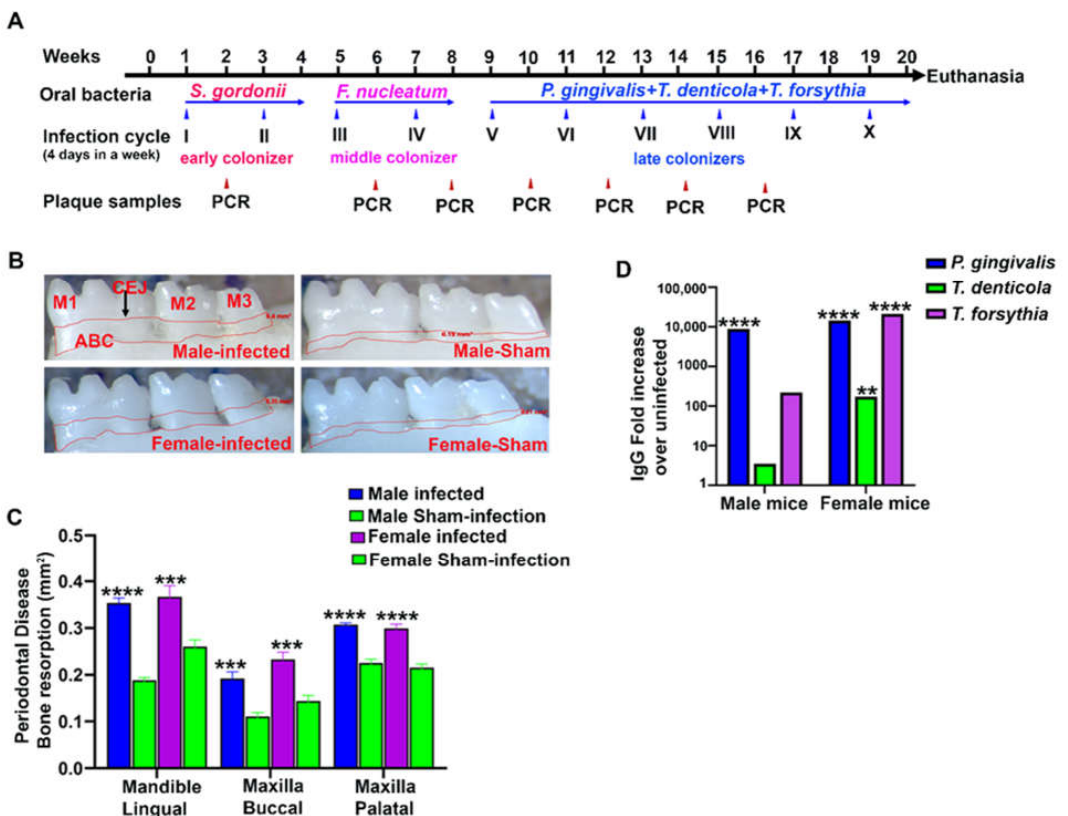
Figure 1. Gingival infection of periodontal bacteria significantly induced alveolar bone resorption (ABR) and elicited an IgG immune response in male and female mice. ( A ) Schematic diagram of the experimental design depicting the ecological time-sequential polybacterial periodontal infection (ETSPPI) model with early, middle, and late colonizers (4 days per week on every alternate week), plaque sampling for PCR and euthanasia. ( B ) Representative images showing horizontal ABR (mandible lingual view) of ETSPPI mice and sham-infected mice with the area of bone resorption outlined from the alveolar bone crest (ABC) to the cementoenamel junction (CEJ). ( C ) Morphometric analysis of the mandible and maxillary ABR in mice. A significant increase in ABR was observed in bacteria-infected mice compared to sham-infected mice (****, p < 0.0001; ***, adjusted p -value = 0.001; ordinary one-way ANOVA). There was no significant difference in ABR between male and female ETSPPI mice. ( D ) Serum IgG antibody levels in male and female mice. In female mice, a significantly higher IgG immune response was observed to P. gingivalis (> 10 4 -fold; ****, p < 0.001), T. forsythia (> 10 4 -fold; ****, p < 0.001), and T. denticola (> 10 2 -fold; **, p < 0.01), whereas a significantly higher IgG immune response was observed only against P. gingivalis (> 10 4 -fold; ****, p < 0.001) in male mice; ordinary one-way ANOVA). Data points and error bars are mean ± SEM ( n =